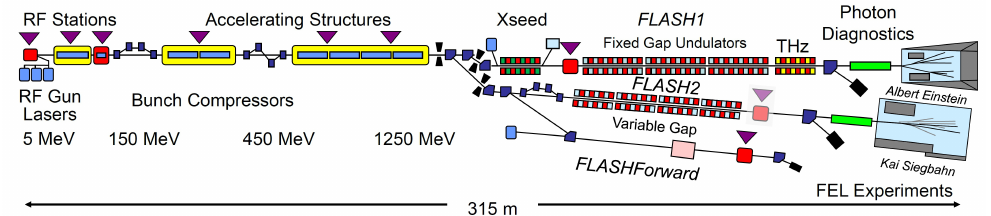
Figure 2. Layout of FLASH